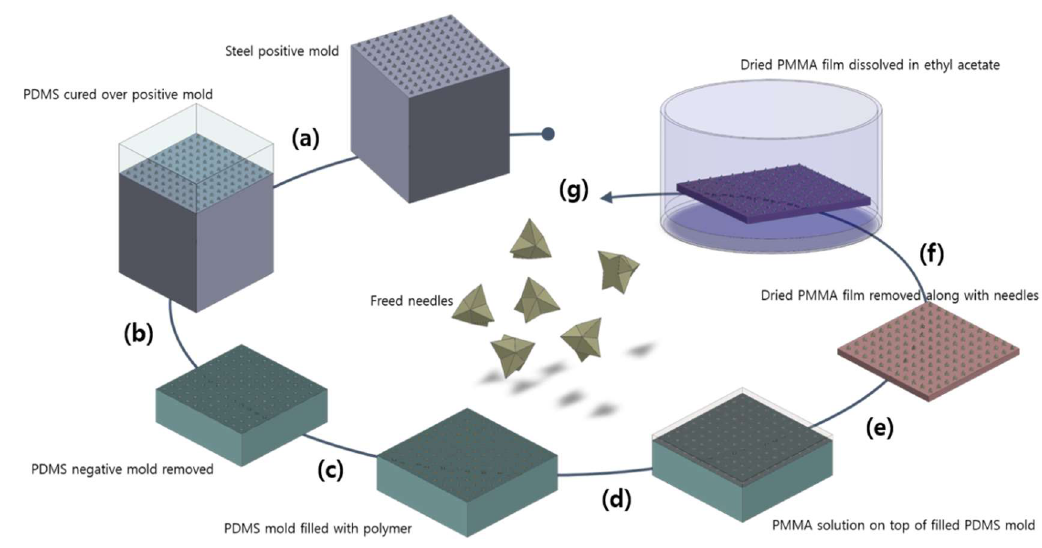
Figure 2. Fabrication process of the MLPs. ( a ) h-PDMS is poured onto the positive steel mold. ( b ) The cured h-PDMS negative mold is removed. ( c ) The negative h-polymethylsiloxane (PDMS) mold is filled with a polymer mixture via vacuum and then dried. ( d ) The PMMA solution in the ethyl acetate is spread on top of the h-PDMS mold and left to evaporate. ( e ) The dried PMMA film is removed from the mold and peeled off along with the dried MLPs. ( f ) The PMMA film is submerged in ethyl acetate for dissolution. ( g ) Needles are freed from the PMMA film and recovered from the ethyl acetate. Images created using SolidWorks (SolidWorks 2015, Dassault Systèmes, Vélizy-Villacoublay, France). By following the modified micromolding method, individual MLPs were successfully created.